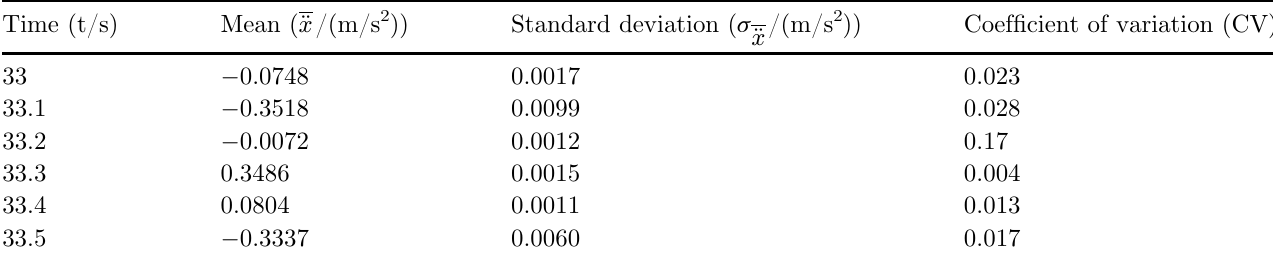
Table 4. Acceleration response mean, standard deviation and coef fi cient of